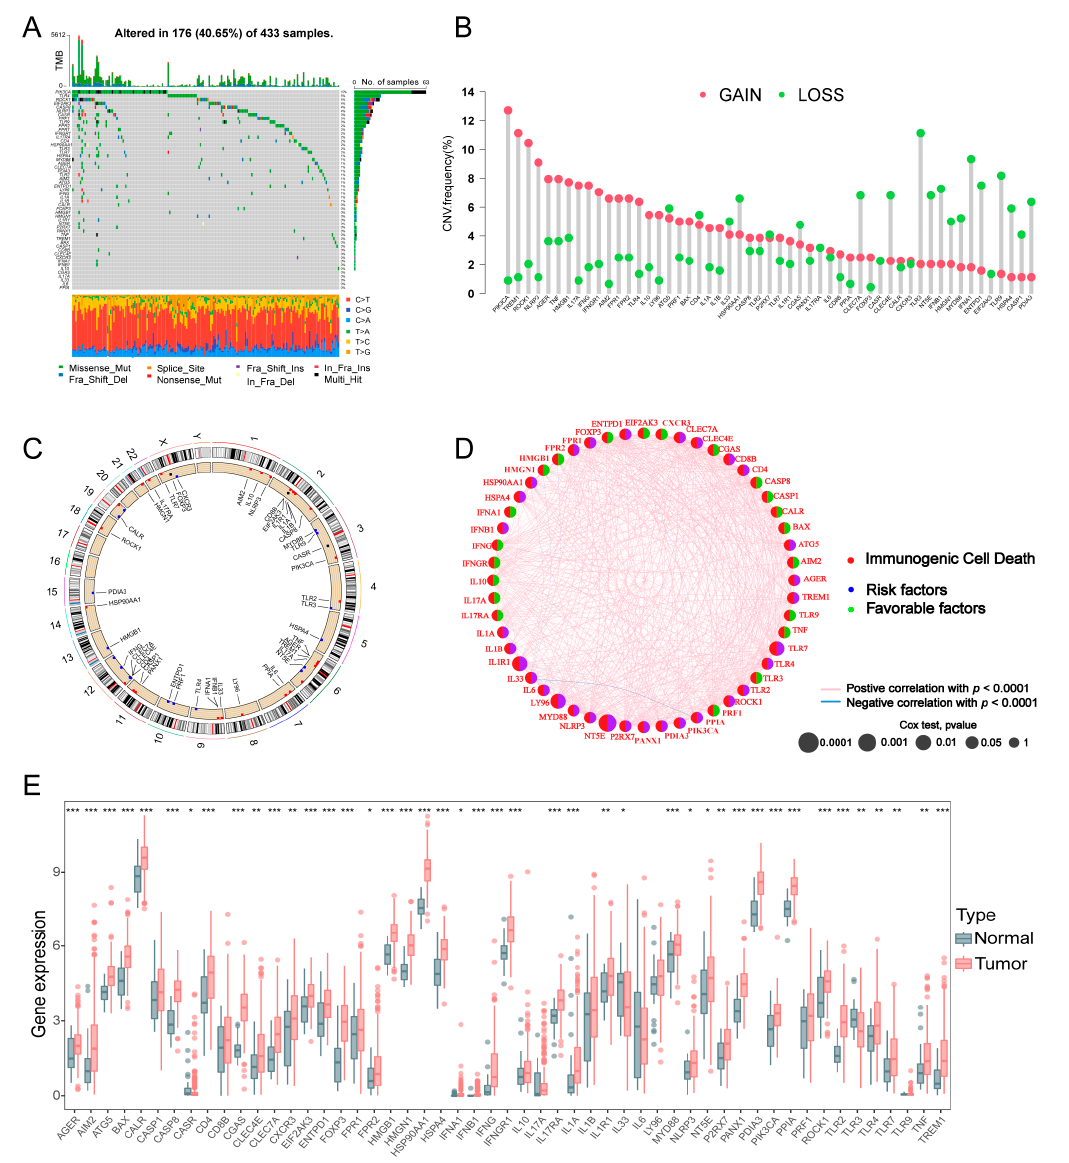
Figure 1. Genetic and transcriptional variations of ICD genes in GC. ( A ) Mutation frequencies of 53 ICD genes in GC patients from the TCGA cohort. ( B ) Frequencies of CNV gain and loss in ICD genes. ( C ) Locations of CNV alterations of ICD genes on 23 chromosomes. ( D ) Interactions and prognostic value of ICD-related genes in GC. ( E ) Differences in expression distributions of 53 ICD genes between GC and normal tissues (tumor, red; normal, grey). p values were shown as: * p < 0.05; ** p < 0.01; *** p < 0.001. ICD, immunogenic cell death; GC, gastric cancer; TCGA, the Cancer Genome Atlas; CNV, copy number variation; OS, overall survival.